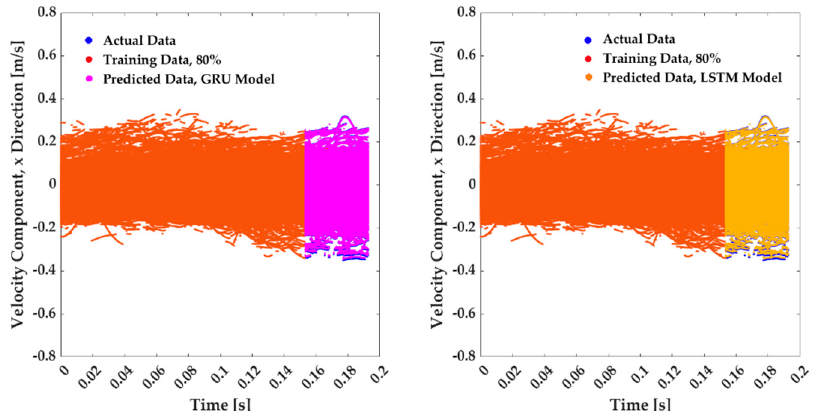
Figure 8. Prediction of velocity component in the y direction for a strained turbulent flow with mean strain rate 8 s − 1 , GRU model on the left ‐ hand side, and LSTM model on the right ‐ hand side. Training data are 60% and test data 40%.